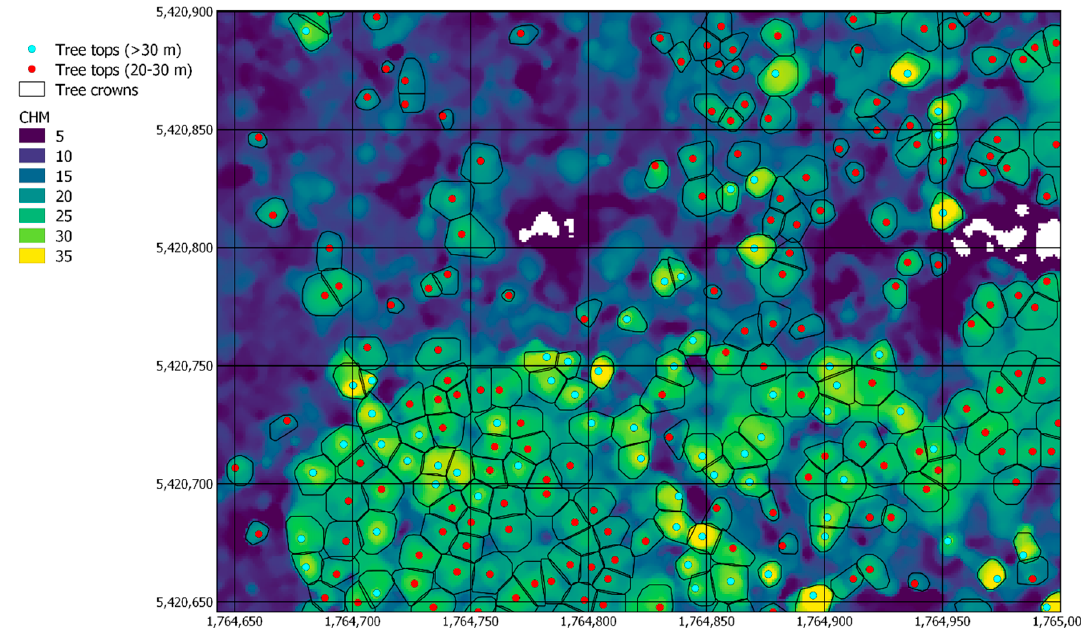
Figure 4. Extract of the canopy height model in the Wellington Region and identified tree tops greater than 30 m tall (cyan) and between 20 and 30 m tall (red). Map projection is NZTM. Table 4. Density of trees (n/ha) in selected tree-height ranges.